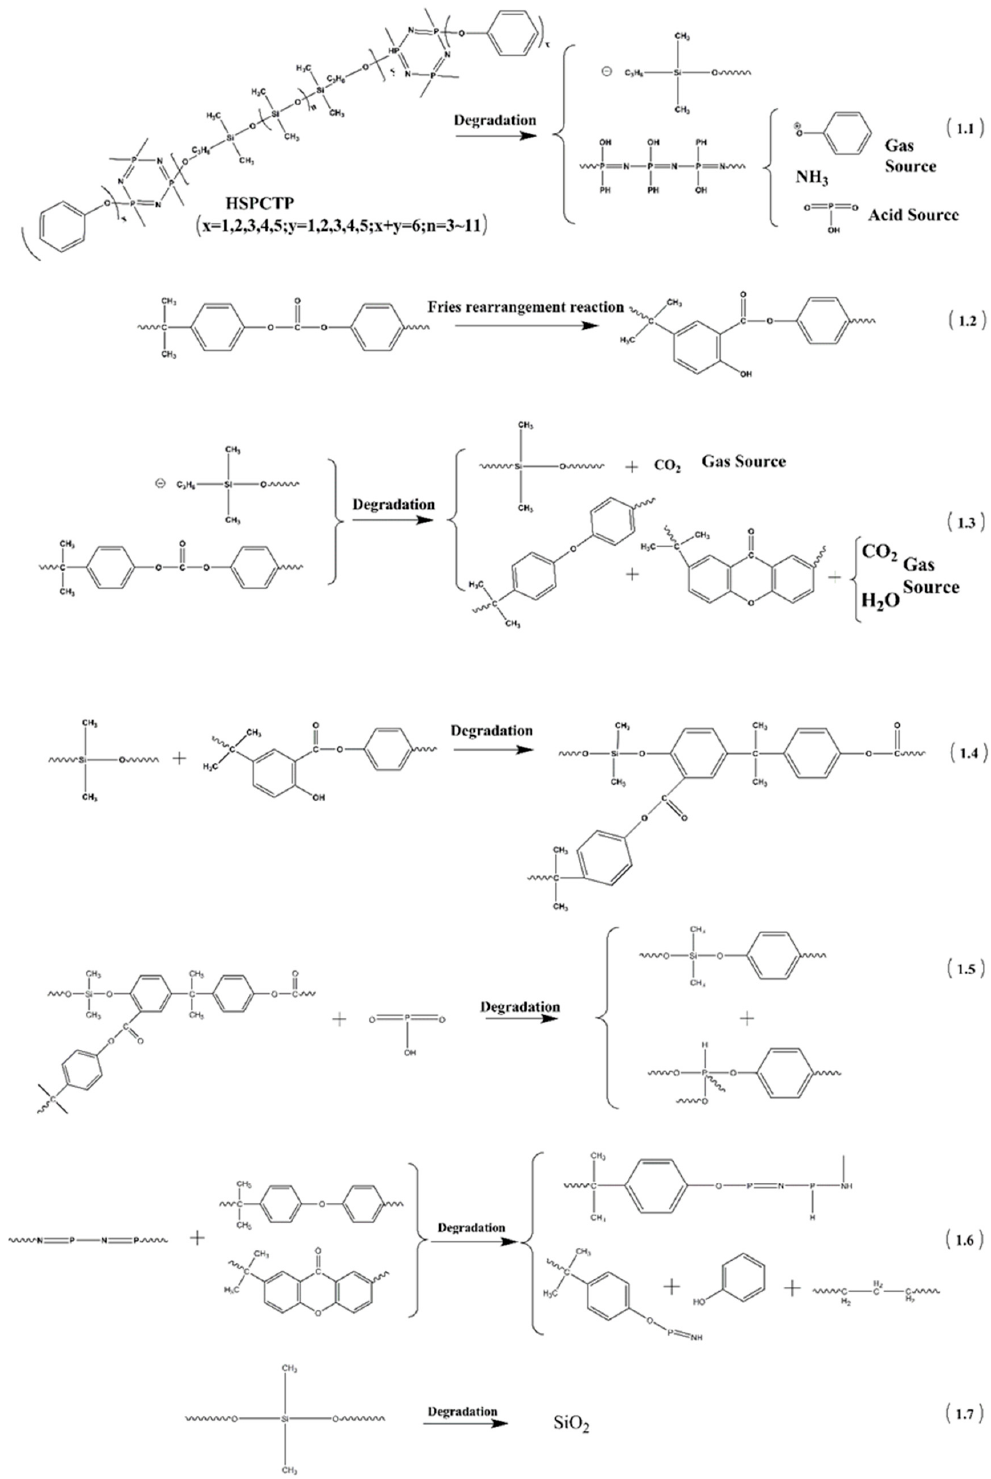
Figure 10. Schematic illustration of the flame-retardant mechanism of PC/HSPCTP composites.